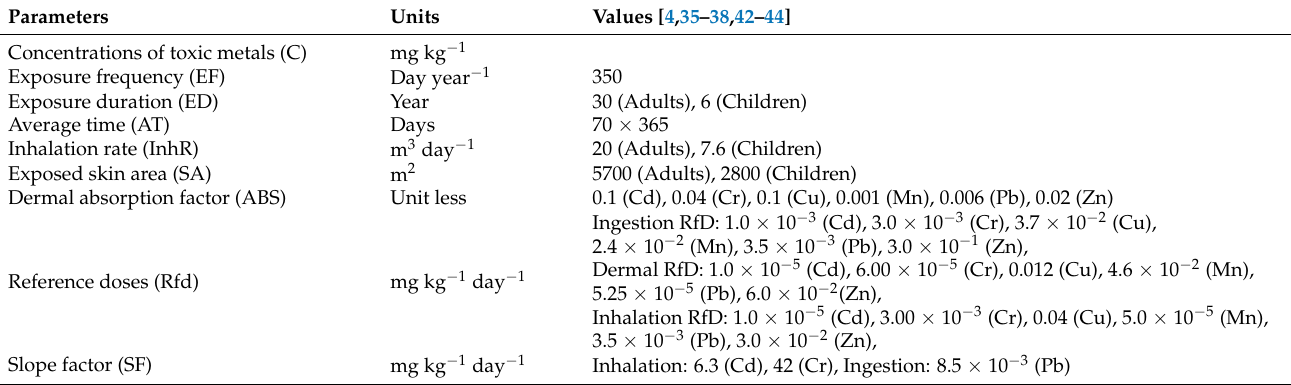
Table 1. The meaning of parameters used in equations to estimate the health